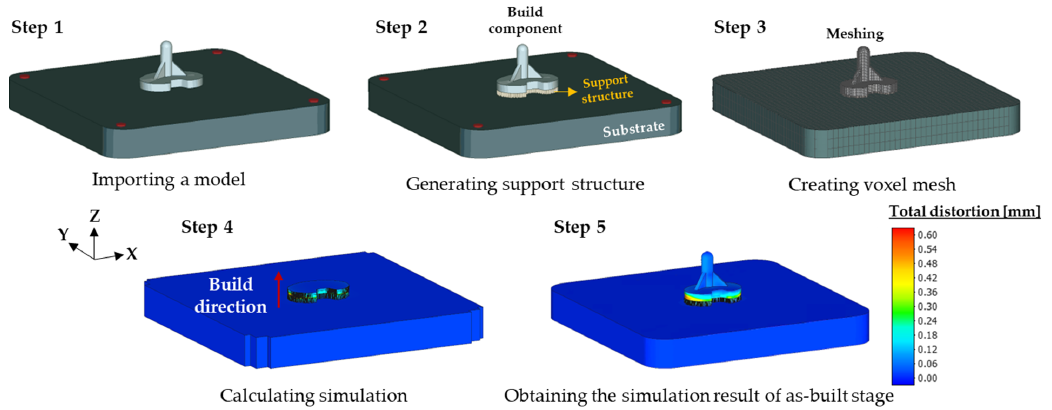
Figure 1. The sequence of numerical modeling using Simufact Additive in the present study. Table 2. Dimensions of tibial components used in this